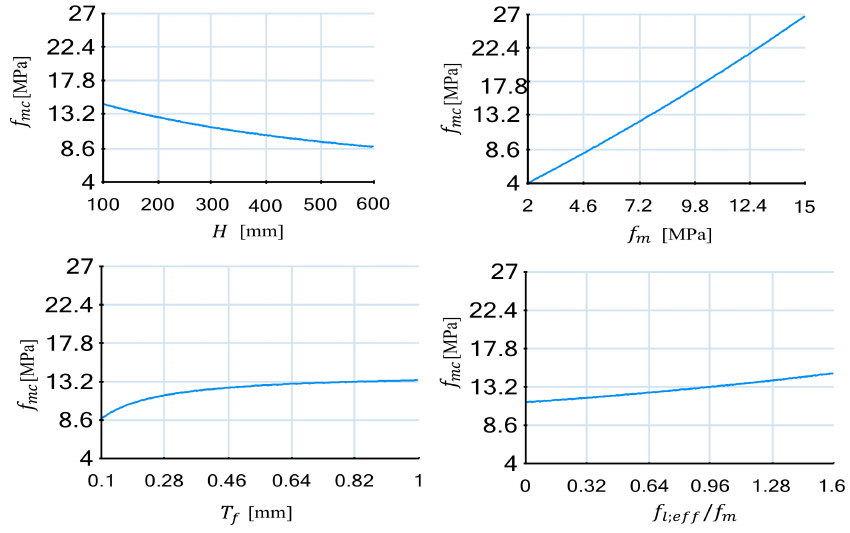
Figure 10. Partial dependence of the simplified model.